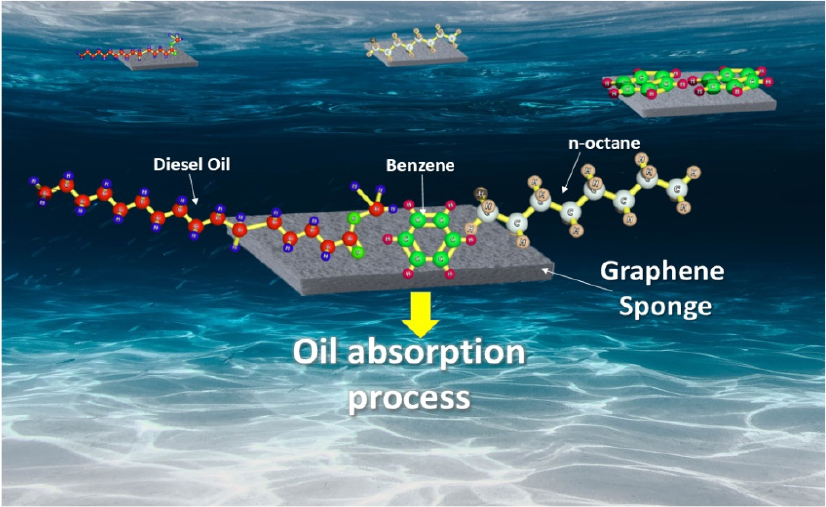
Figure 4. Crude oil derivatives’ absorption via graphene sponge in seawater.